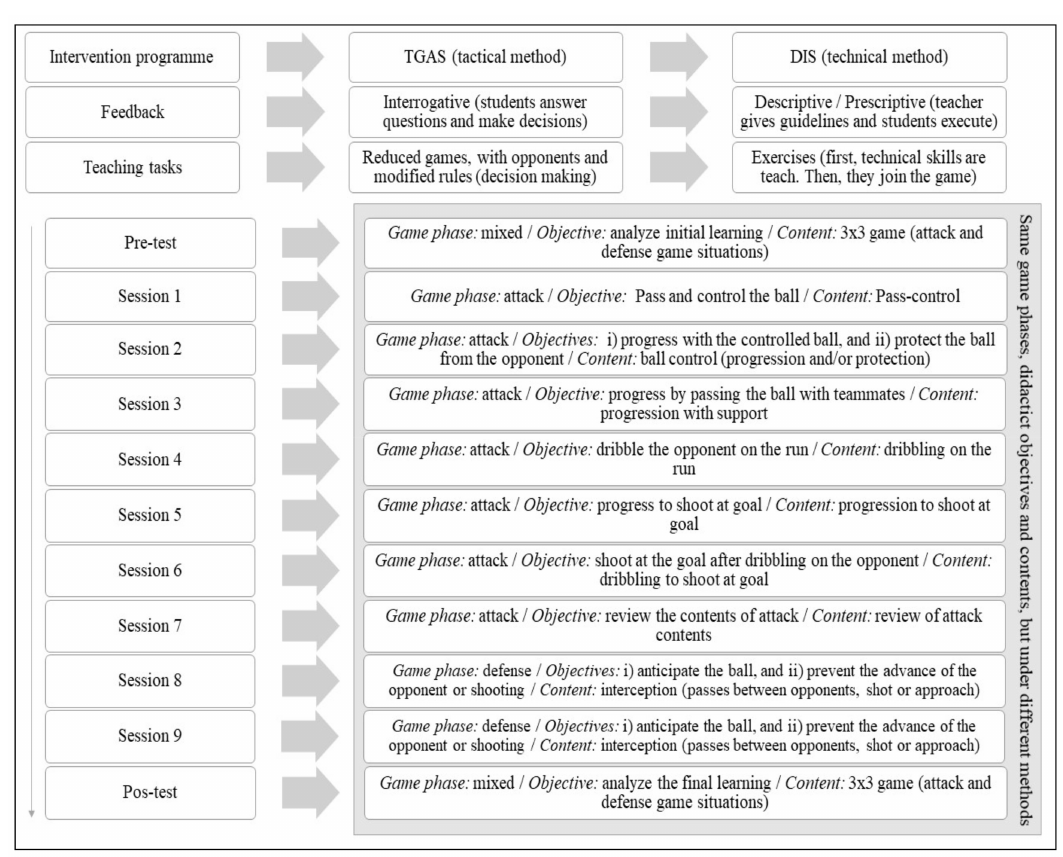
Figure 1. Structure of the TGAS and DIS intervention programmes. Note: TGAS: Tactical Games Approach Soccer. DIS: Direct Instruction